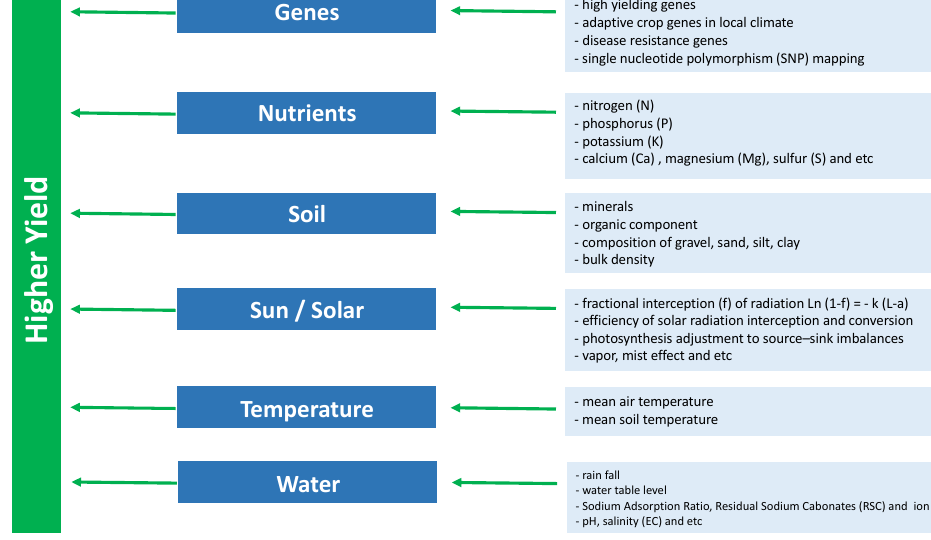
Figure 1. Complex combination of agro-climatic conditions.